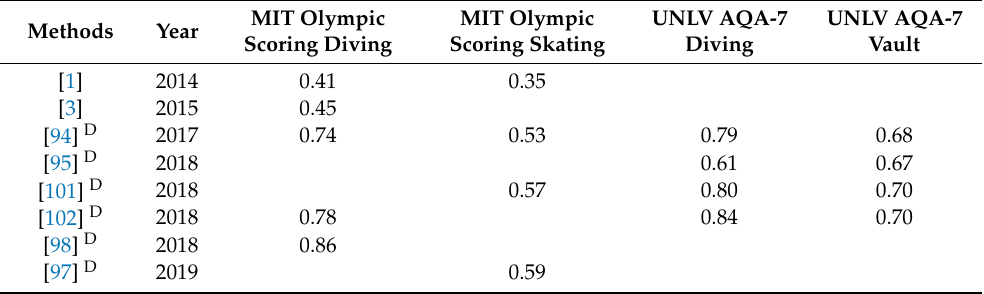
Table 5. Action evaluation performance of methods on sports scoring dataset. The superscript D indicates a deep learning method.